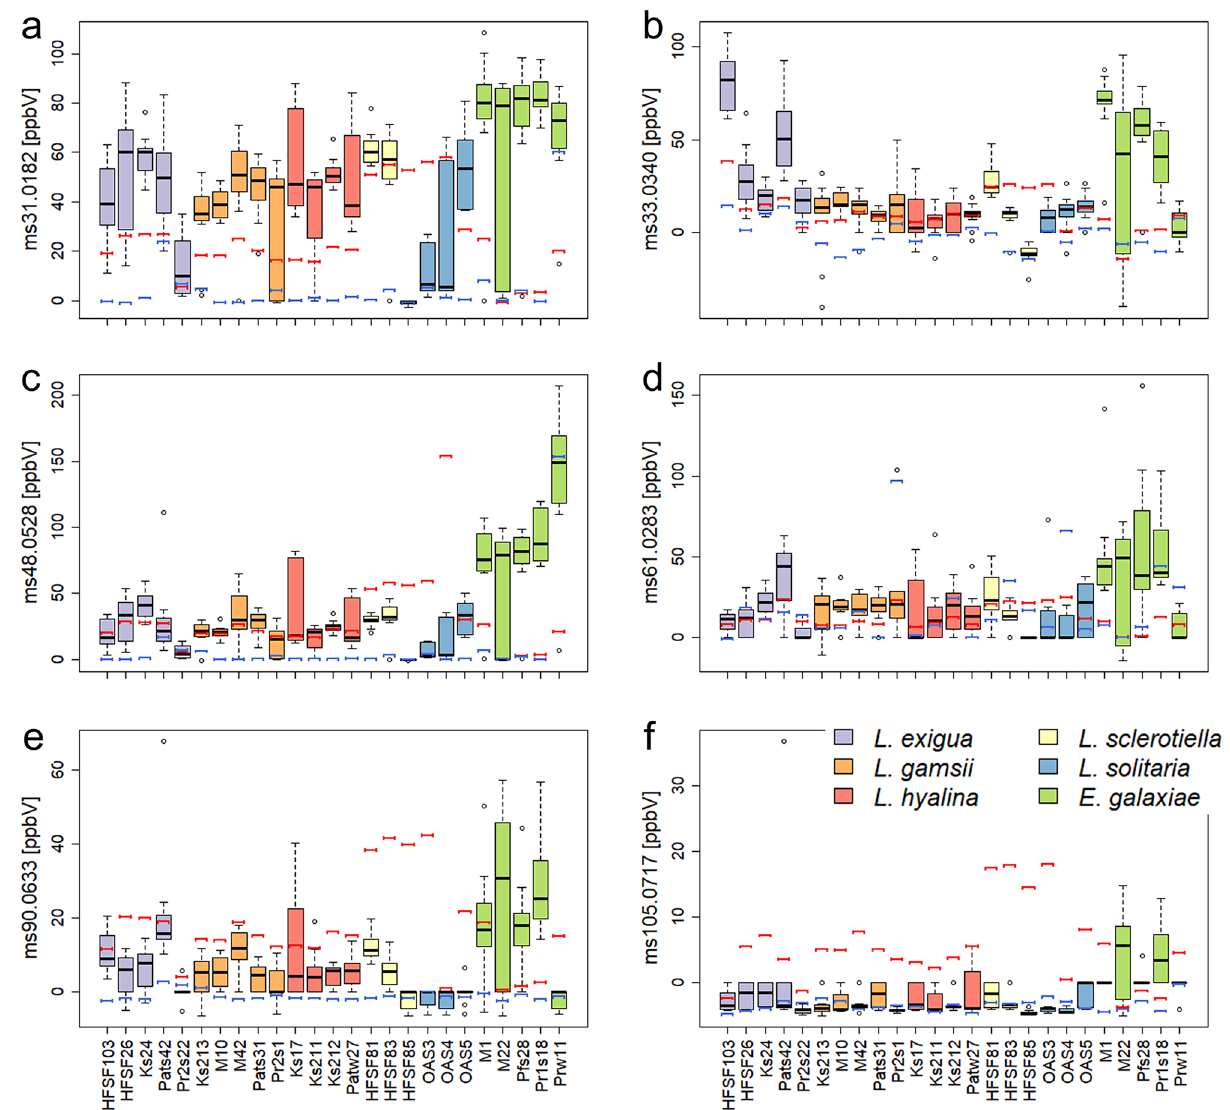
Figure 6. Concentrations of volatile organic compounds (VOCs) that might be potentially regulated in co-cultures of Mortierellaceae strains and P. helmanticensis . Those VOCs whose concentrations in co-culture were not predictable from both pure cultures were identified by linear models. The figure visualizes the measured co-culture concentrations in ppbV in all co-culture sample groups. The red bar indicates the predicted VOC concentration from linear modelling (model 1). The blue bar indicates the pure culture concentration. ( a ) ms31.0182 = tentatively annotated (t.a.) as formaldehyde, ( b ) ms33.0340 = t.a. methanol, ( c ) ms48.0528 = ethanol, ( d ) ms61.0283 = acetic acid, ( e ) ms90.0633 = acetoin, ( f ) ms105.0717 =